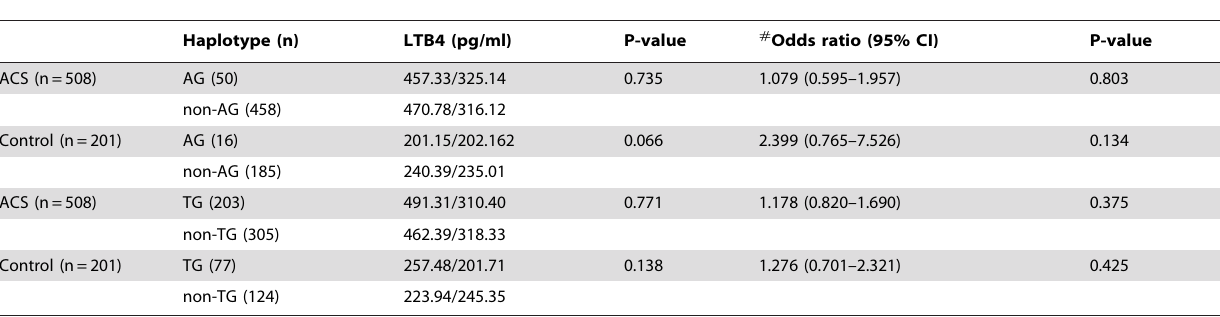
Table 6. Serum LTB4 levels and haplotypes in ACS and control